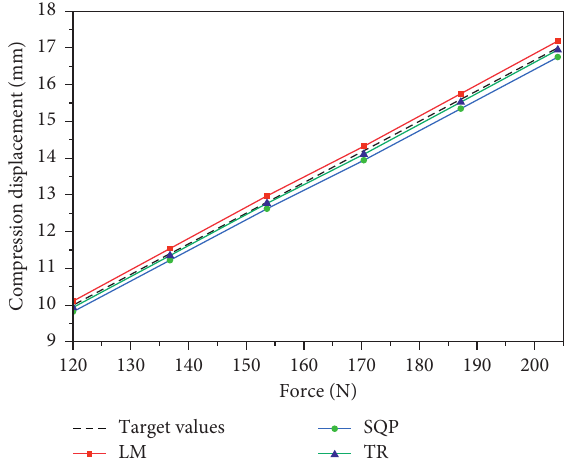
Figure 10: Designed stiffness of springs for each algorithm.